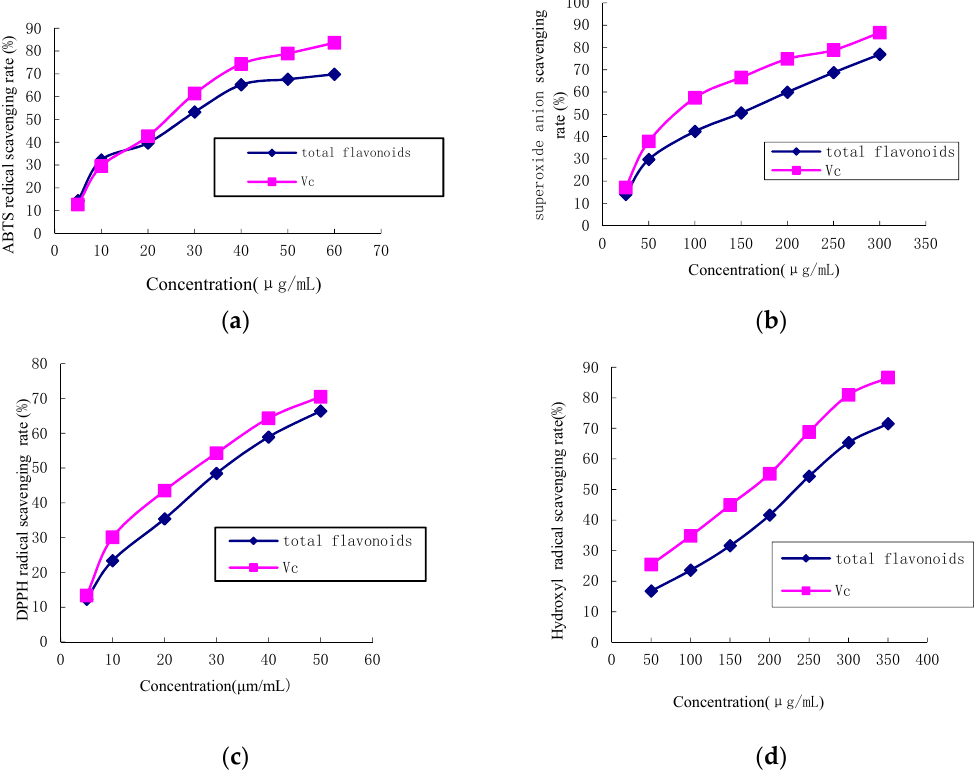
Figure 2. Effects of total flavonoids on radical scavenging rates: ( a ) Curve of ABTS scavenging rate; ( b ) curve of superoxide anion scavenging rate; ( c ) curve of DPPH radical scavenging rate; ( d ) curve of •OH scavenging rate.